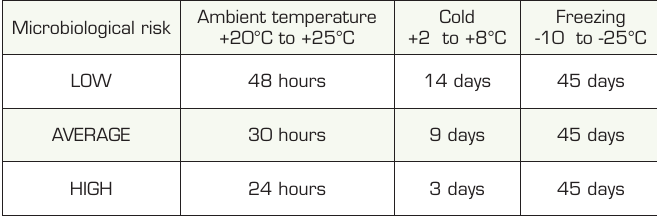
Table 8 : duration of microbiological stability for preparations produced in the hospital in accordance with USP <797> under reserve of physico- chemical stability